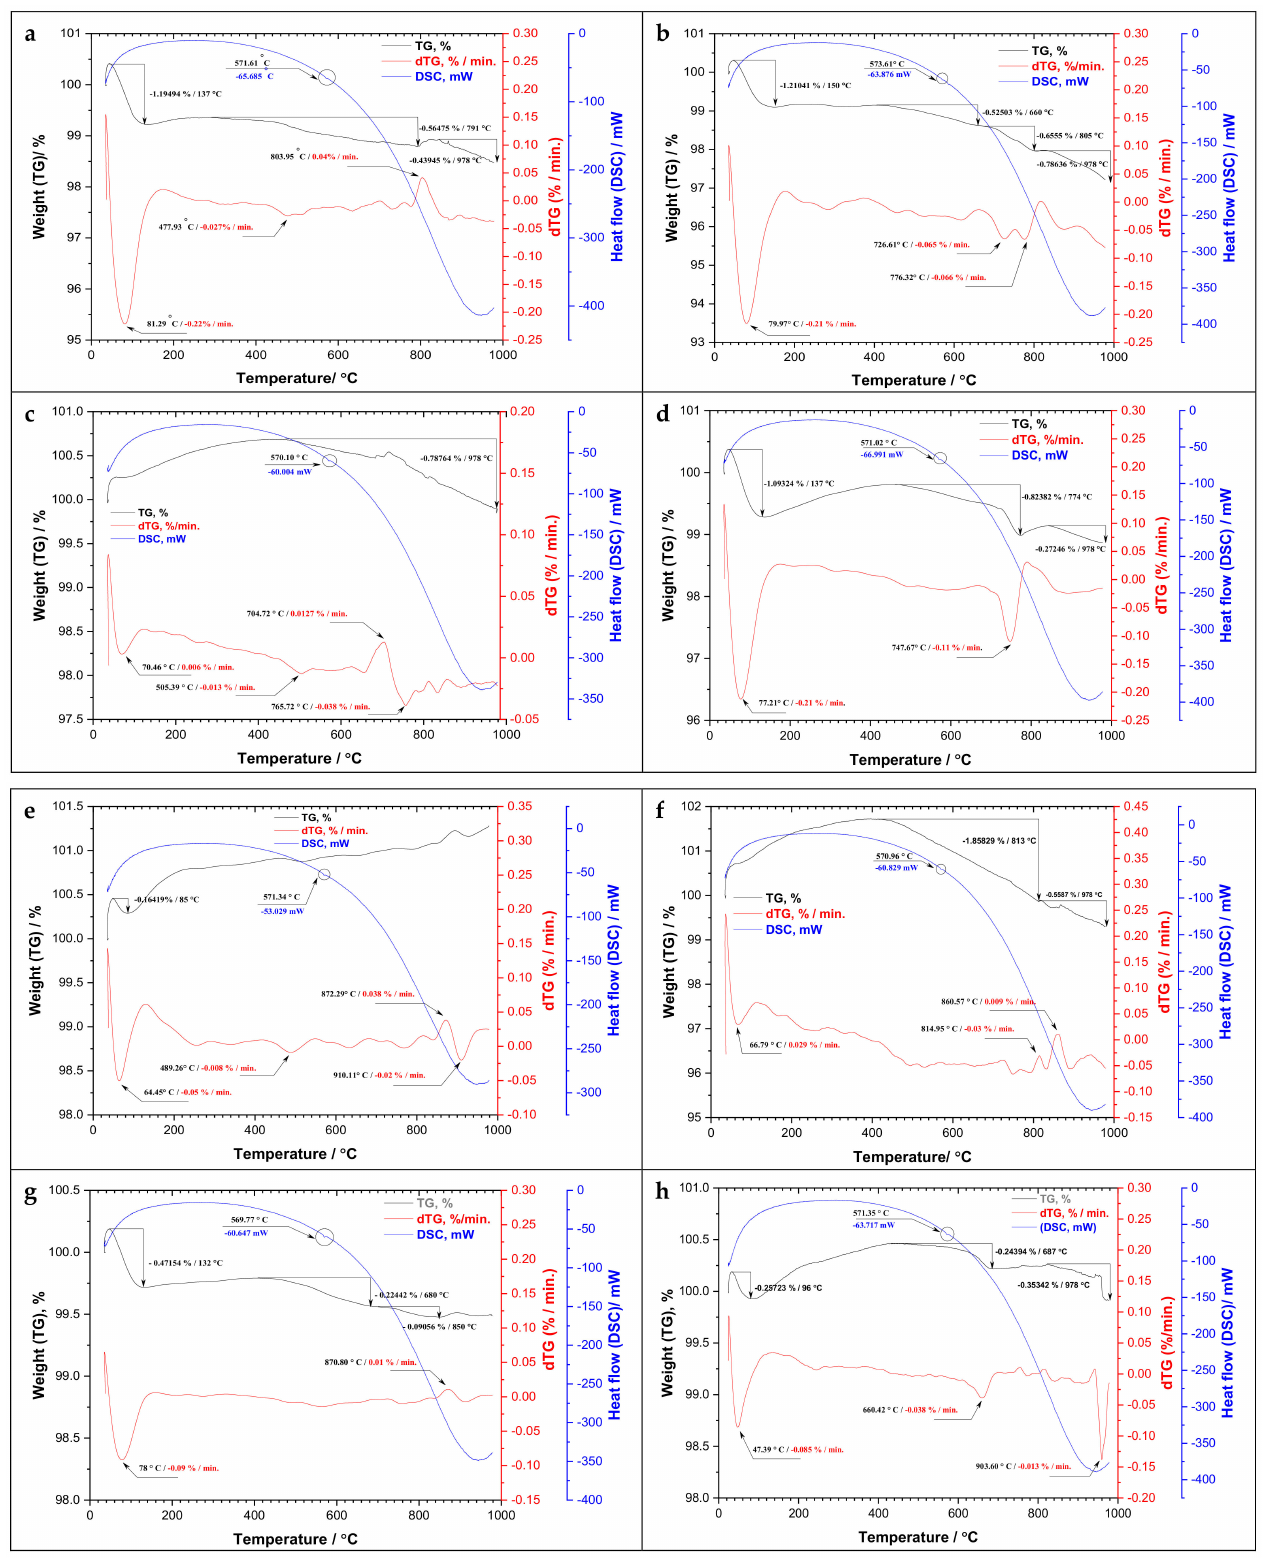
Figure 6. Thermogravimetric analysis of different granitic rocks using TG/DTG/DSC: ( a ) gandonna; ( b ) pink granite; ( c ) buff graniteI; ( d ) buff graniteII; ( e ) fantazia; ( f ) red granite ( g ) rosa granite; ( h ) qusseir brown. A circle shape represents the phase transition of α - β quartz at 573 ◦